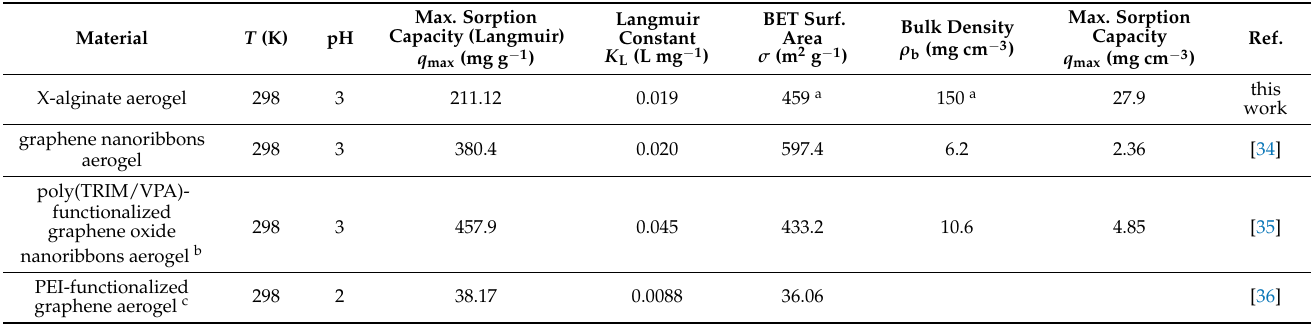
Table 1. Th(IV) sorption capacity from laboratory solutions and selected material properties of different aerogel